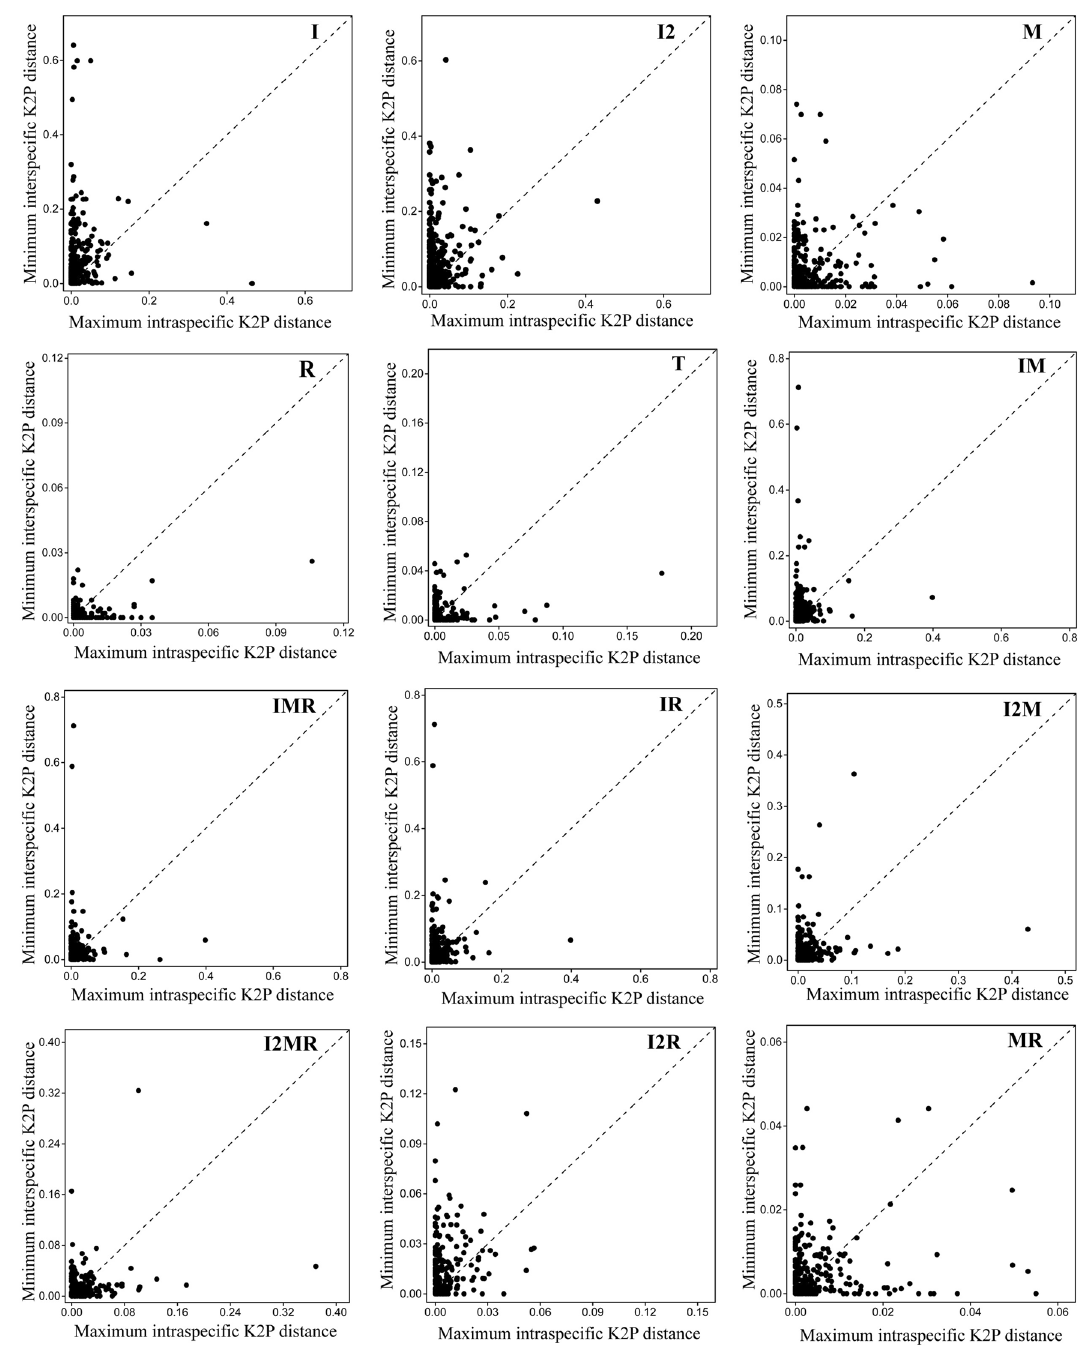
Figure 3. Scatter plots of the maximum intraspecific versus minimum interspecific K2P distance for five single markers and seven combinations (I, ITS; I2, ITS2; M, matK ; R, rbcL ; T, trnH-psbA Species discrimination. Neighbour-joining (NJ) trees obtained from the majority of barcodes exhibited nearly similar topology (Supplementary Figs. S2-S13) and agreed with the core phylogenetic hypothesis of Orchidaceae (e.g. 35 ). Species discrimination rates among single-locus ranged from 53% ( rbcL ) to 90% (ITS), where matK and trnH – psbA performed 67.56% and 66.11% respectively. Among the 2-loci combinations, dis- crimination range comprised 70.12% ( matK + rbcL ) to 80% (ITS + matK ). In the 3-loci combinations, highest species discrimination was exhibited by ITS + matK + rbcL (70.20%), whereas ITS2 + matK + rbcL had 68.24% (Table 3).